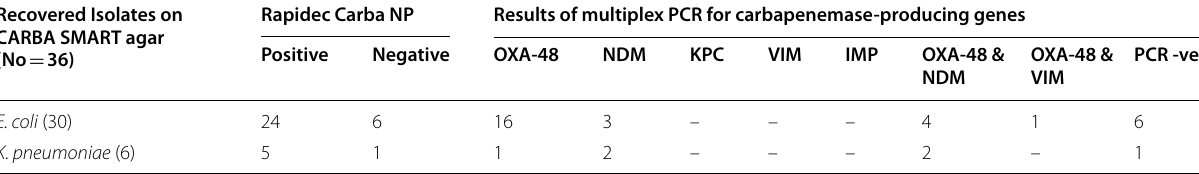
Results of multiplex PCR for carbapenemase-producing